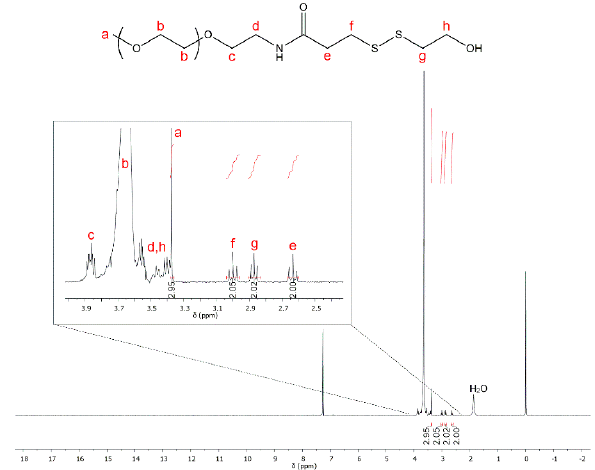
Figure 3. 1 H NMR spectrum of the modified polymer P1 (step 2, CDCl 3 , 25 °C).